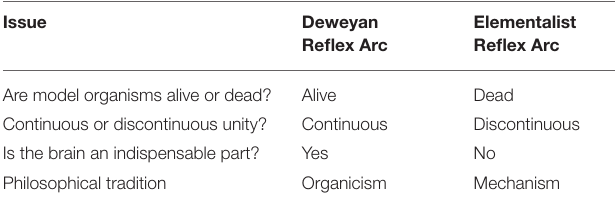
TABLE 1 | Four issues on which the Deweyan reflex arc and the elementalist reflex arc